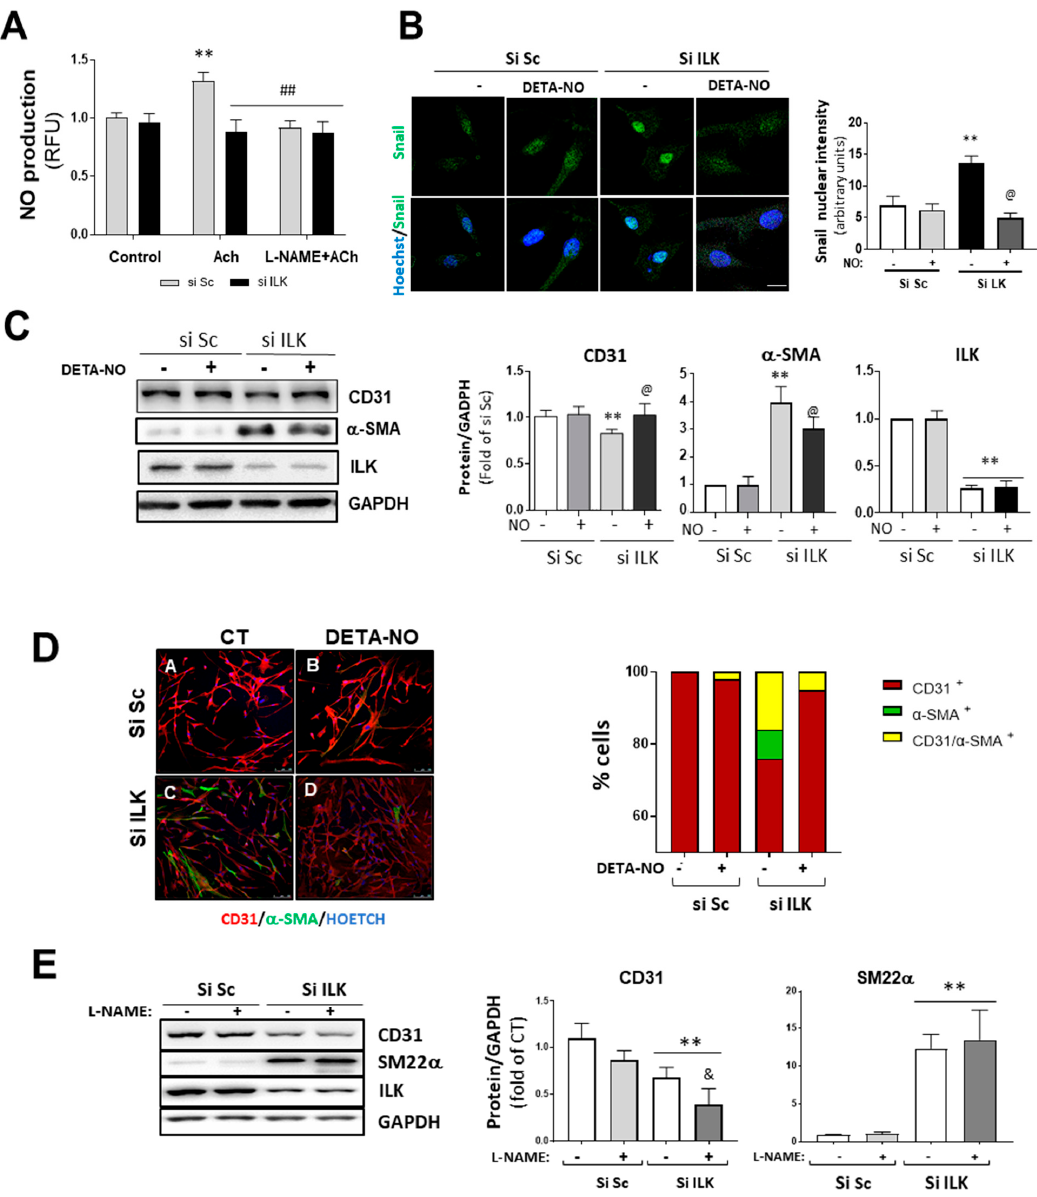
Figure 3. Nitric oxide prevents EndMT in hVECs. ( A ) Flow cytometry analysis of NO production in hVECs transfected with siSc or silk for 3 days. Cells were pre ‐ treated with saline buffer (Control), Acetylcholine (ACh), L ‐ NAME, or a combination thereof, according to the experimental procedure. n = 6. ** p < 0.001 vs. control; ## p < 0.001 vs. Si Sc treated with Ach. ( B ) Confocal fluorescent micros ‐ copy images of SNAIL in transfected hVECs treated with the NO donor DETA ‐ NONOate (DETA ‐ NO) for 5 days (left). Nuclei were counterstained with Hoechst. Nuclear intensity quantification is represented on the right. Scale bar = 10 μ m. n = 6. ** p < 0.001 vs. Si Sc; @ p < 0.001 vs. Si ILK without NO. ( C ) Western blot analysis (left) and quantification (right) of ILK, CD31, and alpha ‐ smooth mus ‐ cle actin ( α‐ SMA) in transfected hVECs and treated with the NO donor DETA ‐ NONOate (DETA ‐ NO) for 5 days. n = 6. ** p < 0.001 vs. Si Sc; @ p < 0.001 vs. Si ILK without NO. ( D ) Double immuno ‐ fluorescence of CD31 (red) and α‐ SMA (green) of hVECs in the same conditions as those in (A). Cell nuclei were counterstained with Hoechst. n = 10. Scale bar = 100 μ m. ( E ) Western blot analysis (left) and quantification (right) of CD31 and alpha ‐ smooth muscle actin ( α‐ SMA) in transfected hVECs treated with the NOS inhibitor L ‐ NAME for 5 days. n = 6. ** p < 0.001 vs. Si Sc; & p < 0.001 vs. Si ILK without L ‐ NAME.